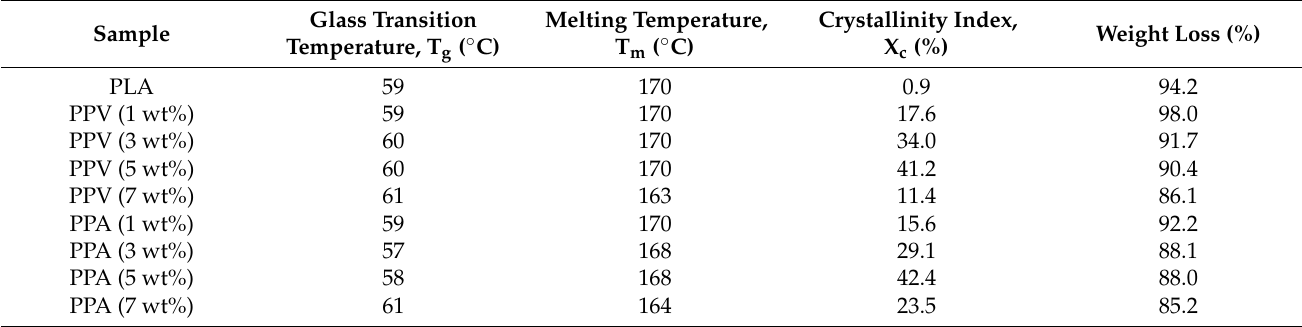
Figure 6. Thermogravimetric analysis (TGA) and differential scanning calorimeter (DSC) curves of PLA nanocomposites with different proportions of PPV (Paly-VTMS) and PPA (Paly-APTES) addition in air ( a , b ) and in argon atmosphere ( c , d ). Table 2. Thermal parameters obtained from thermogravimetric analysis (TGA) and differential scanning calorimeter (DSC) analysis (in argon). PPV,